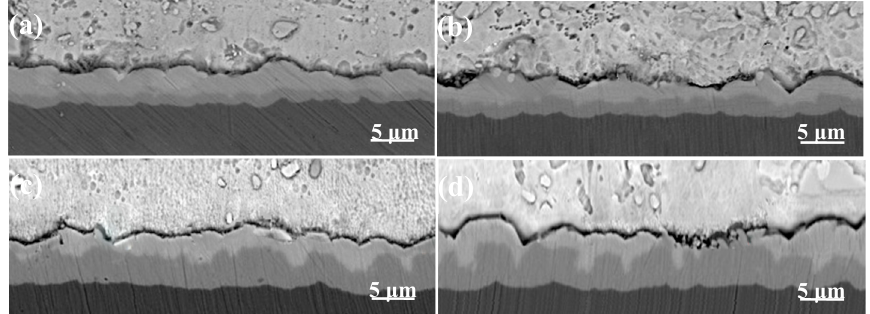
Figure 4. SEM images of the interfacial morphology at SAC0307-0.05Pr solder/Cu interfaces aged at 150 °C for different hrs: ( a ) 72 h; ( b ) 240 h; ( c ) 528 h; ( d ) 840 h.